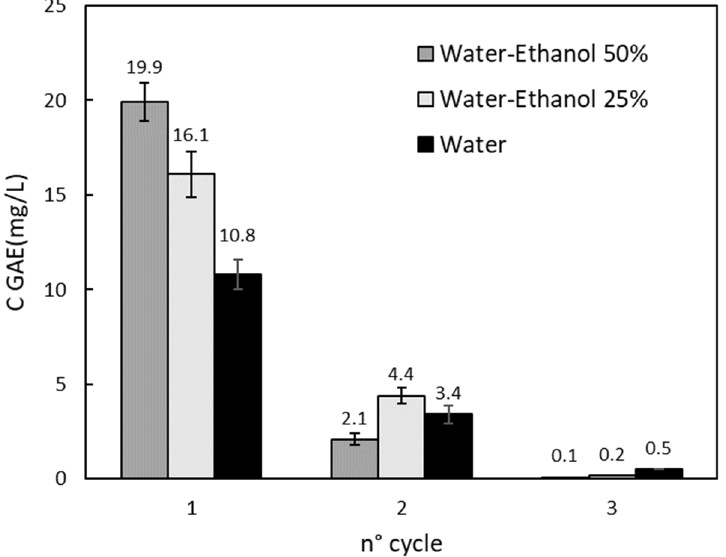
Figure 1. Equivalent Gallic Acid concentration (C GAE) along three pre-treatment cycles using water, water–ethanol (25% v / v ), and water–ethanol (50% v / v ) solutions as solvents.